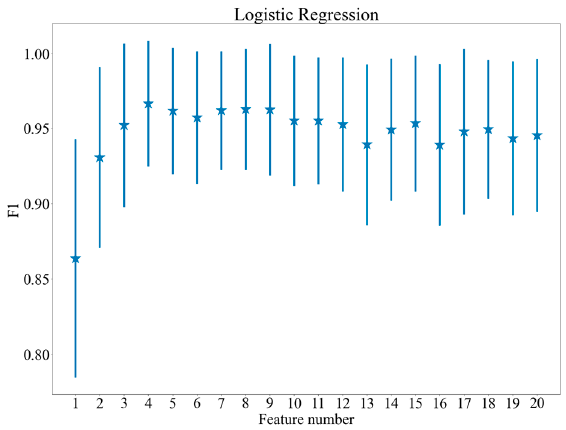
Figure 5. F1 scores for various feature numbers. Logistic Regression.